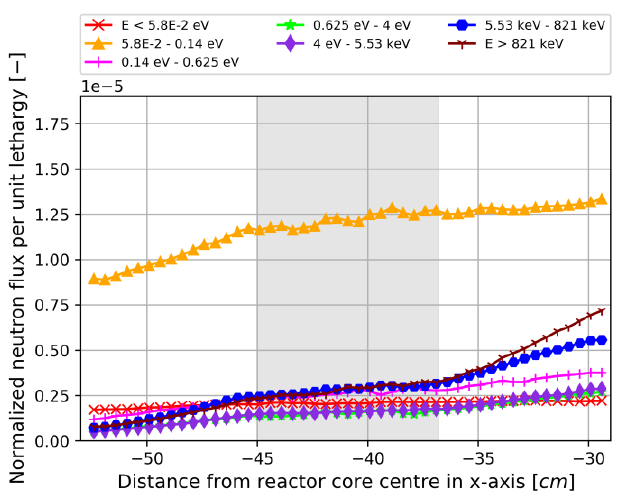
Fig. 3. Neutron flux profile in the graphite reflector – CASE 2. The 7-group structure, ENDF/B-VII.1 [6]